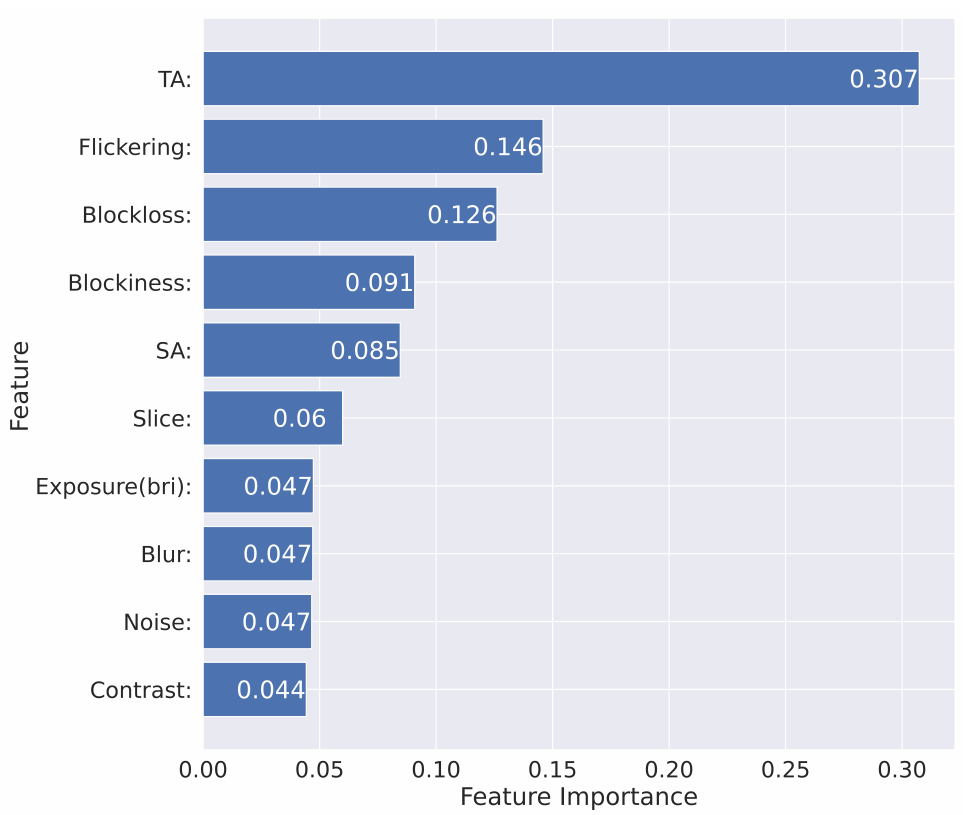
Figure 4. Importance of the XGBoost feature in sample classification.